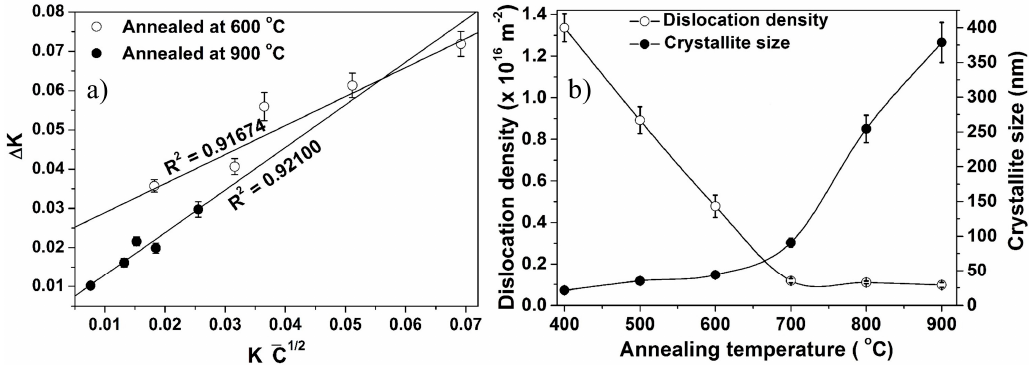
Figure 7. ( a ) MWH plot of Fe–10Cr–3Al alloy powder after annealing at 600 and 900 °C for 30 min